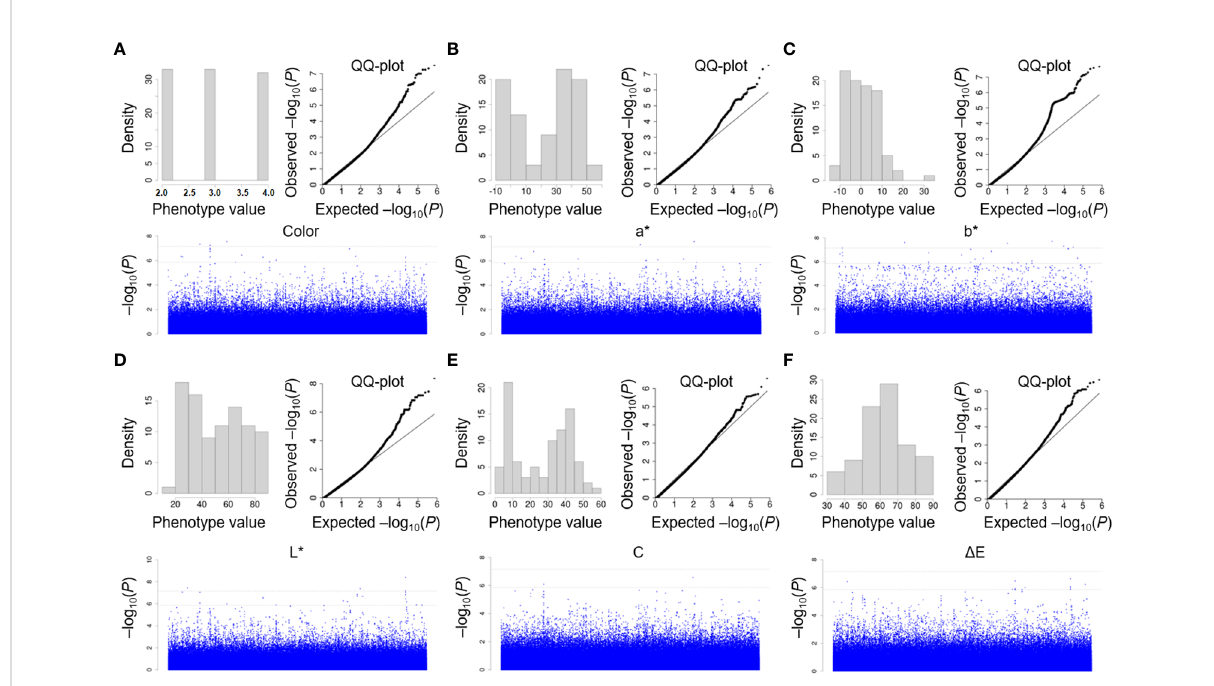
FIGURE 6 Association study of color indices in P. lacti fl ora population using MLM model. Manhattan plots of association study by MLM model for color (A) , a* (B) , b* (C) , L* (D) , C (E) and D E (F) , respectively. The test threshold is shown as a dash black line (at P < 0.01 and P ≤ 0.05). Each SNP is marked by a